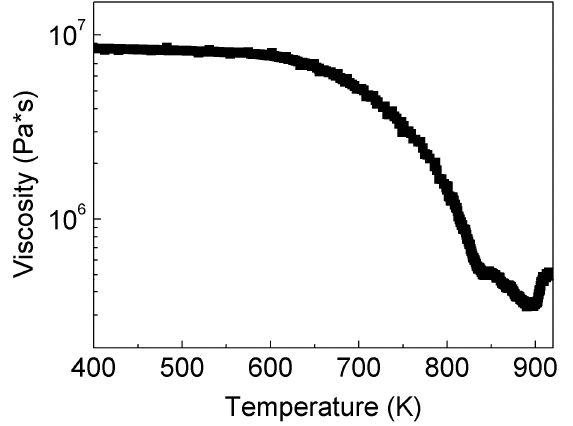
Figure 11. Temperature dependence (heating rate 30 K/min) of the viscosity of the supercooled liquid for the glass-brass composite powder with 60 vol.% glass milled for 20